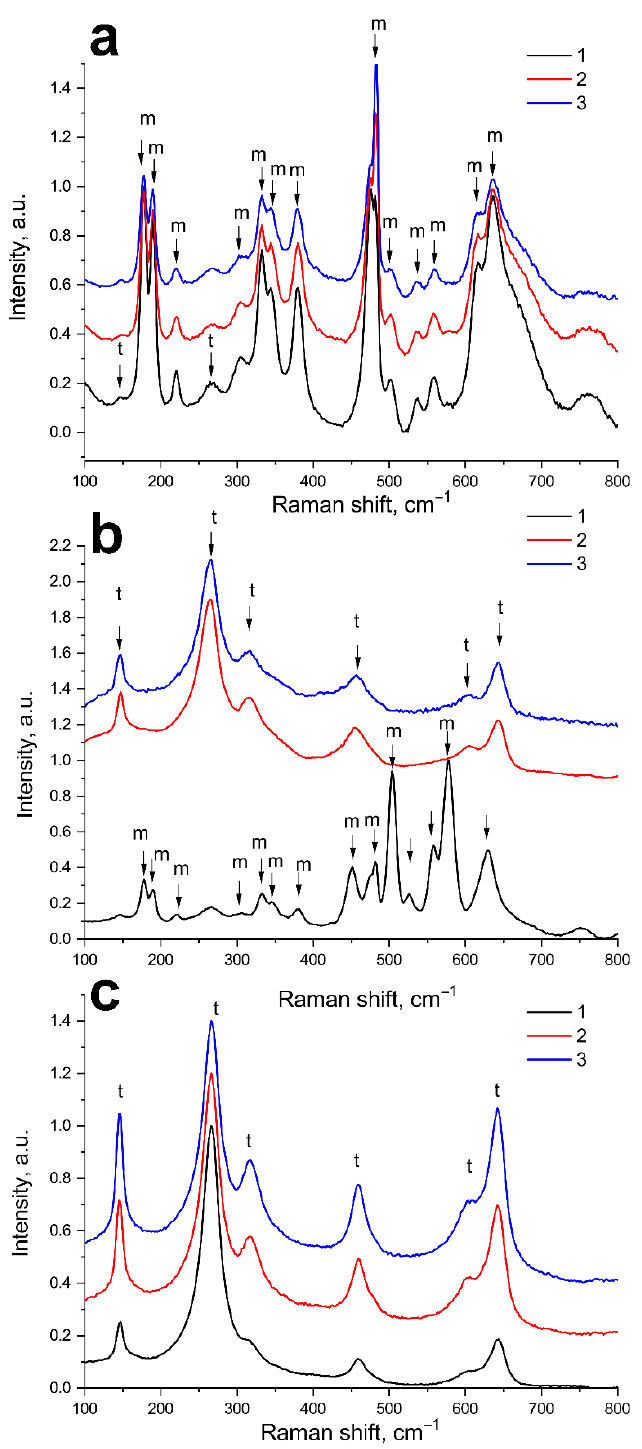
Figure 2. Raman spectra of (ZrO 2 ) 1-x (Sm 2 O 3 ) x crystals: ( a ) (ZrO 2 ) 0.98 (Sm 2 O 3 ) 0.02 , ( b ) (ZrO 2 ) 0.097 (Sm 2 O 3 ) 0.03 and ( c ) (ZrO 2 ) 0.96 (Sm 2 O 3 ) 0.04 ; (1) crystal bottom, (2) crystal middle part and (3) crystal top. The spectra of the (ZrO 2 ) 0.98 (Sm 2 O 3 ) 0.02 crystals exhibit monoclinic phase bands and weak tetragonal phase bands along the whole crystal (Figure 2a). The spectra of the (ZrO 2 ) 0.96 (Sm 2 O 3 ) 0.04 crystals (Figure 2c) exhibit tetragonal phase bands only. For a Sm 2 O 3 concentration of 3 mol.% (Figure 2b), the monoclinic phase dominates in the bottom part of the crystal, whereas the spectra for the rest of the crystal have patterns similar to those typical of the tetragonal phase [26].